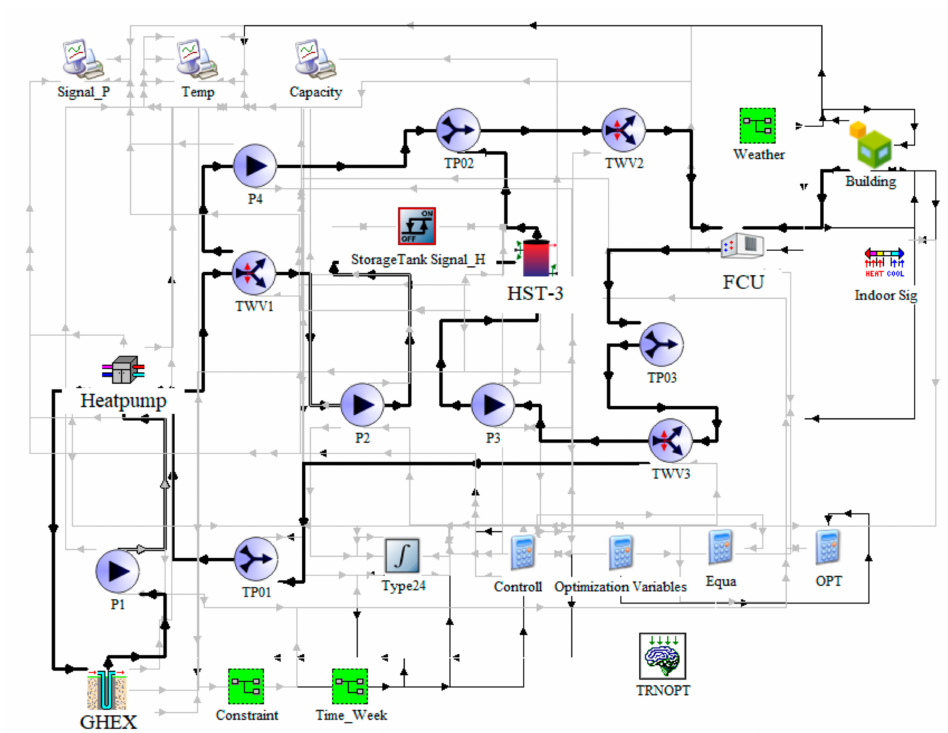
Figure 7. Simulation model with GSHP and optimization model in TRNSYS.